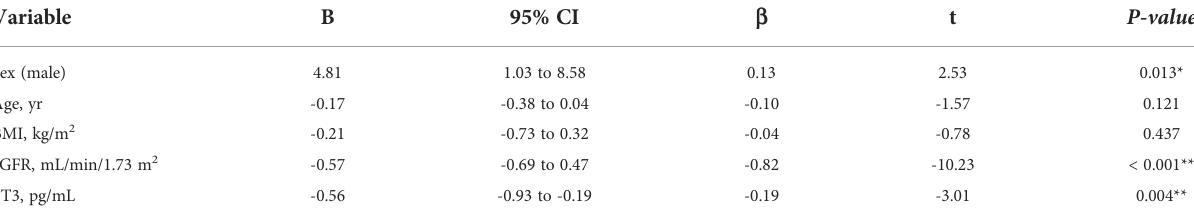
TABLE 3A Multiple regression analysis of D eGFR and variables in hyperthyroidism. (A) Adjusted for sex, age, BMI, eGFR and FT3. Variable